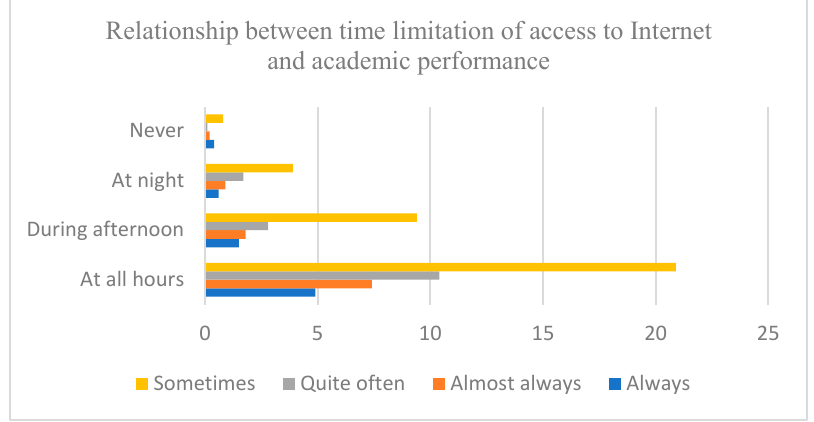
Figure 2. Relationship between time limitation of access to Internet and academic performance. Note: Y axis: When do you have Internet access? Axis X = Academic performance negatively affected by the use of